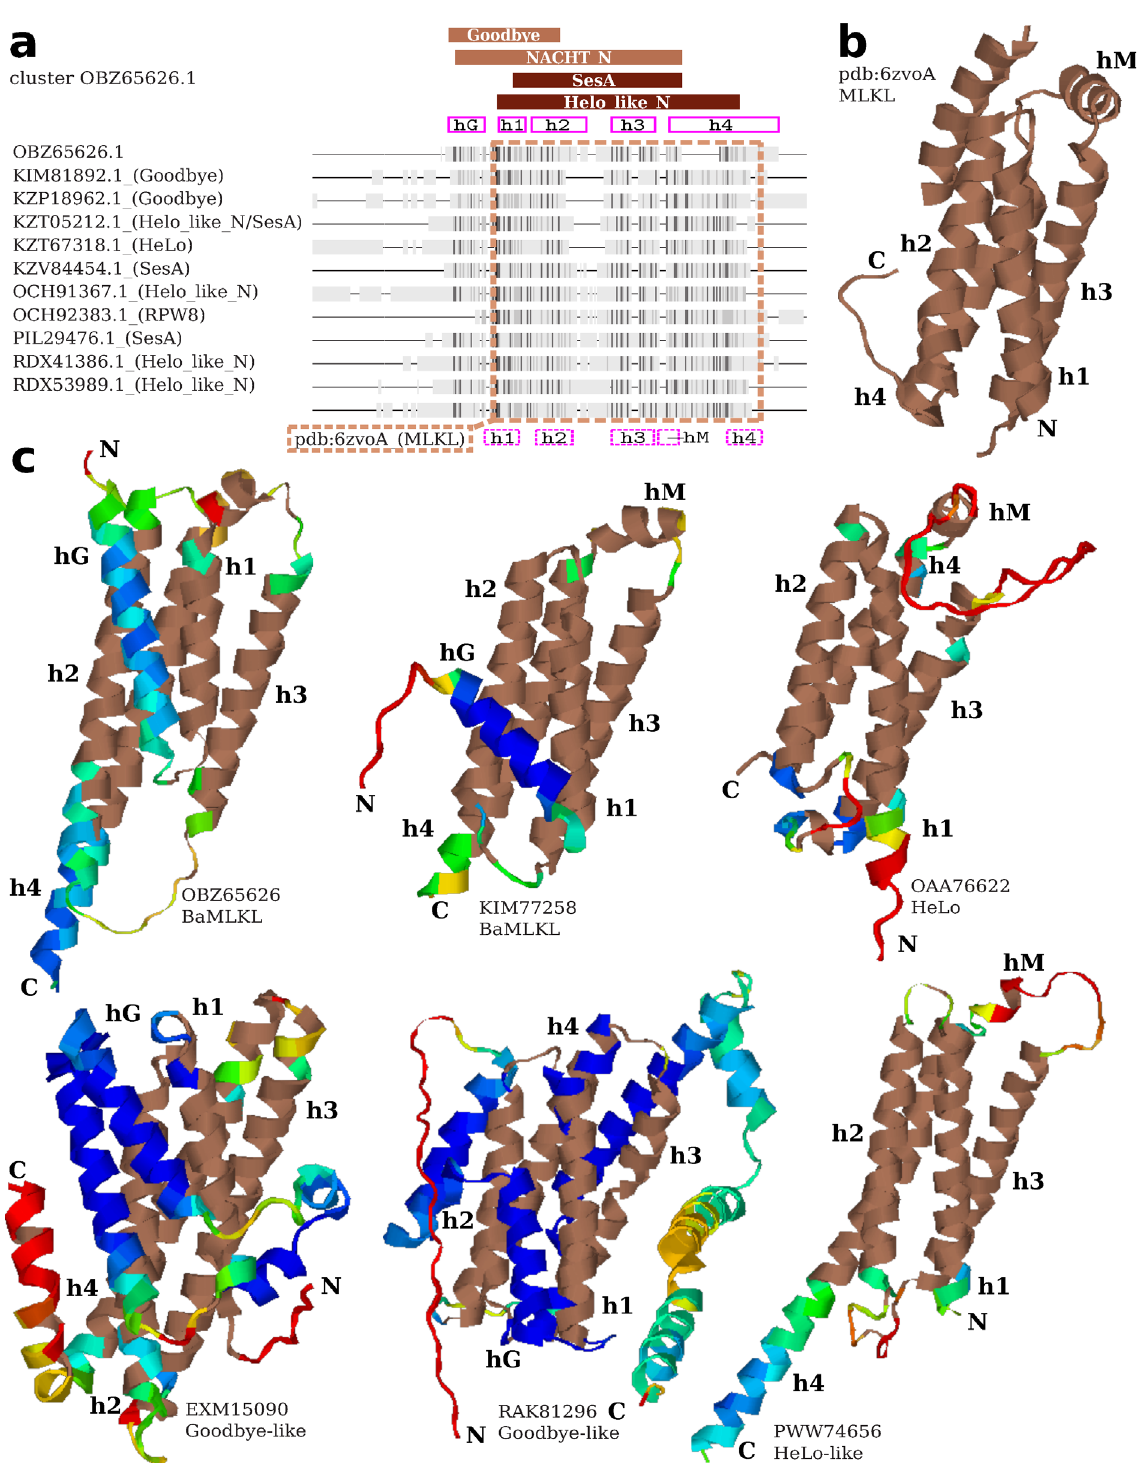
Fig 2. MLKL-like N-termini. a ) Fingerprint alignment of the doubly (Goodbye-like & Helo-like) annotated OBZ65626 cluster including non- redundant sequences with direct Pfam annotations. The alignment was truncated C-terminally. Darker shade implies higher conservation, while gaps are represented as lines. Columns matched with Pfam profiles of MLKL-like domains are indicated with brown bars. Columns corresponding to helices in a predicted OBZ65626 model are indicated with solid magenta boxes. Columns alignable to the human MLKL structure are framed with a brown dashed line. Columns corresponding to helices in the aligned MLKL structure are indicated with